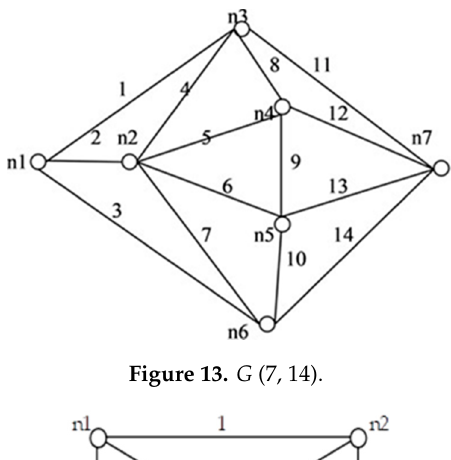
Figure 12. G (8, 11).